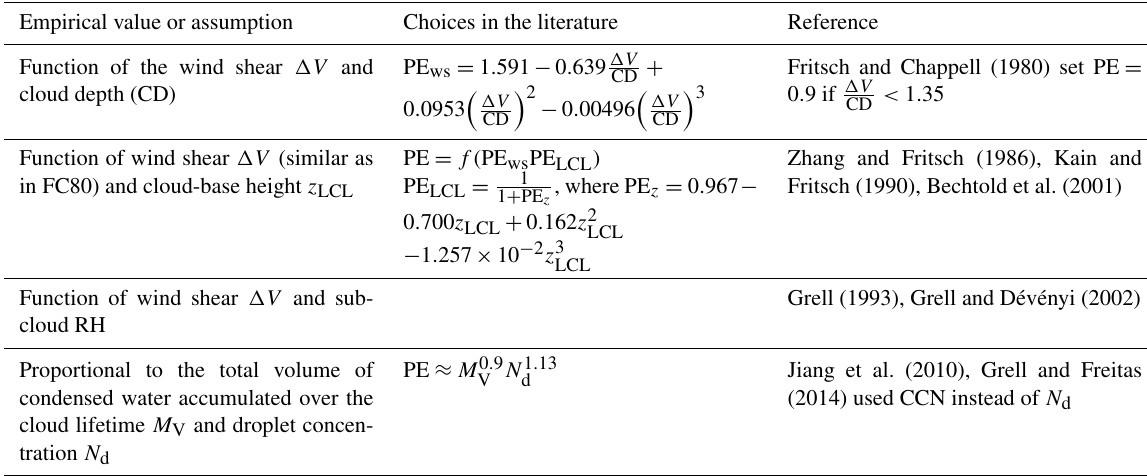
Table 9. A sample of empirical values and assumptions used in precipitation efficiency accounting for evaporation. Empirical value or assumption Choices in the literature Reference Function of the wind shear (cid:49)V